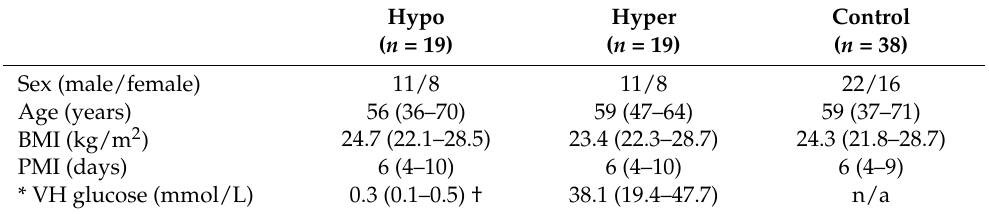
Table 1. Case characteristics for the study groups included in the main multivariate model building.